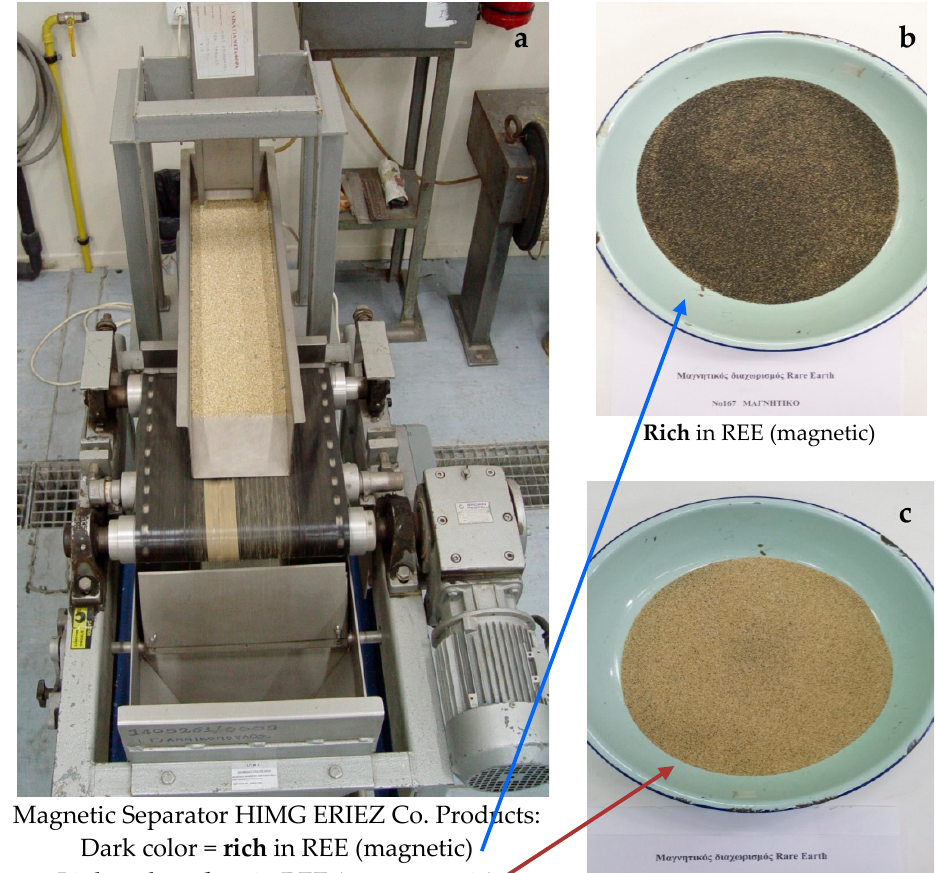
Figure 2. ( a ) Magnetic Separator HIMG ERIEZ Co. and products of separation, ( b ) dark colored magnetic product and, ( c ) non-magnetic product.